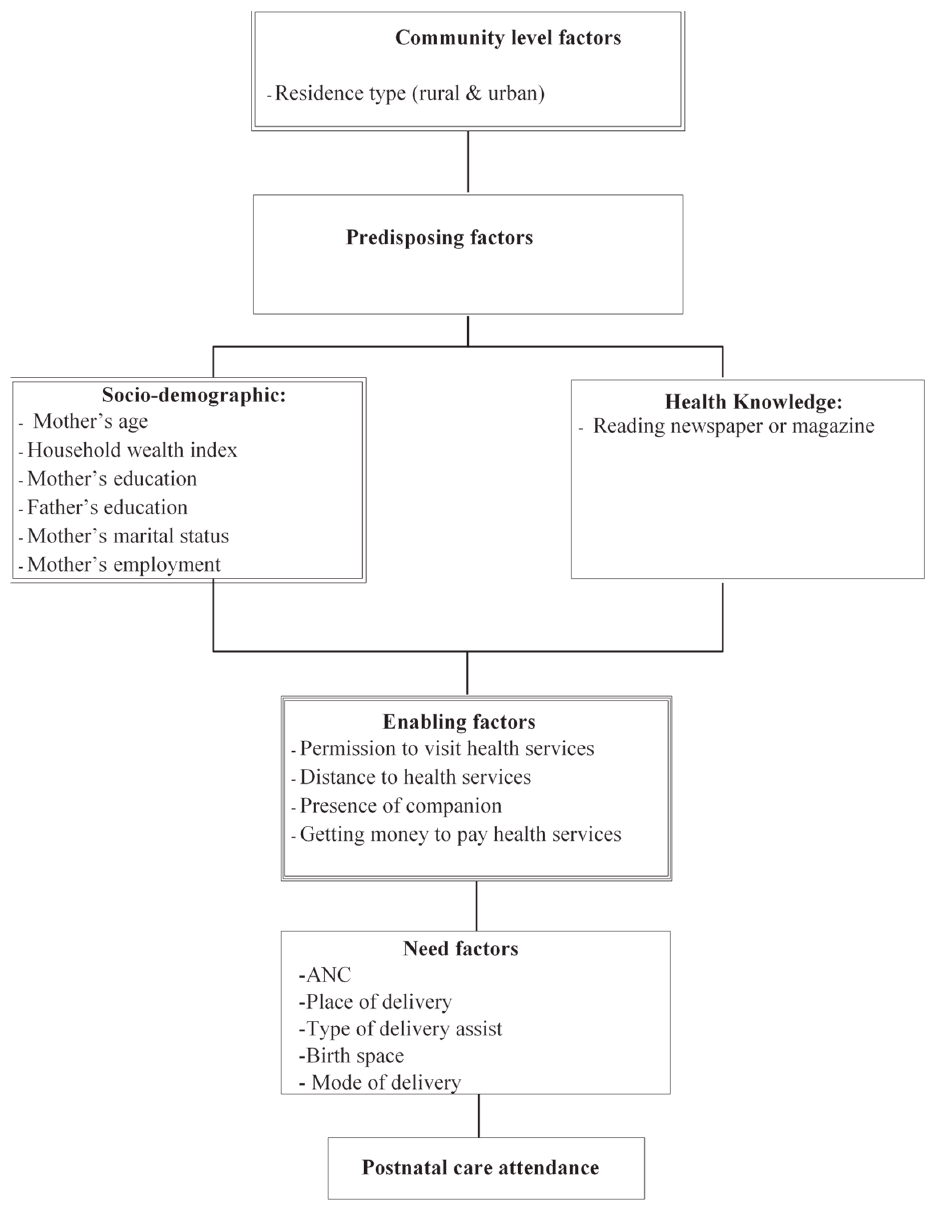
Figure 1. Conceptual framework.